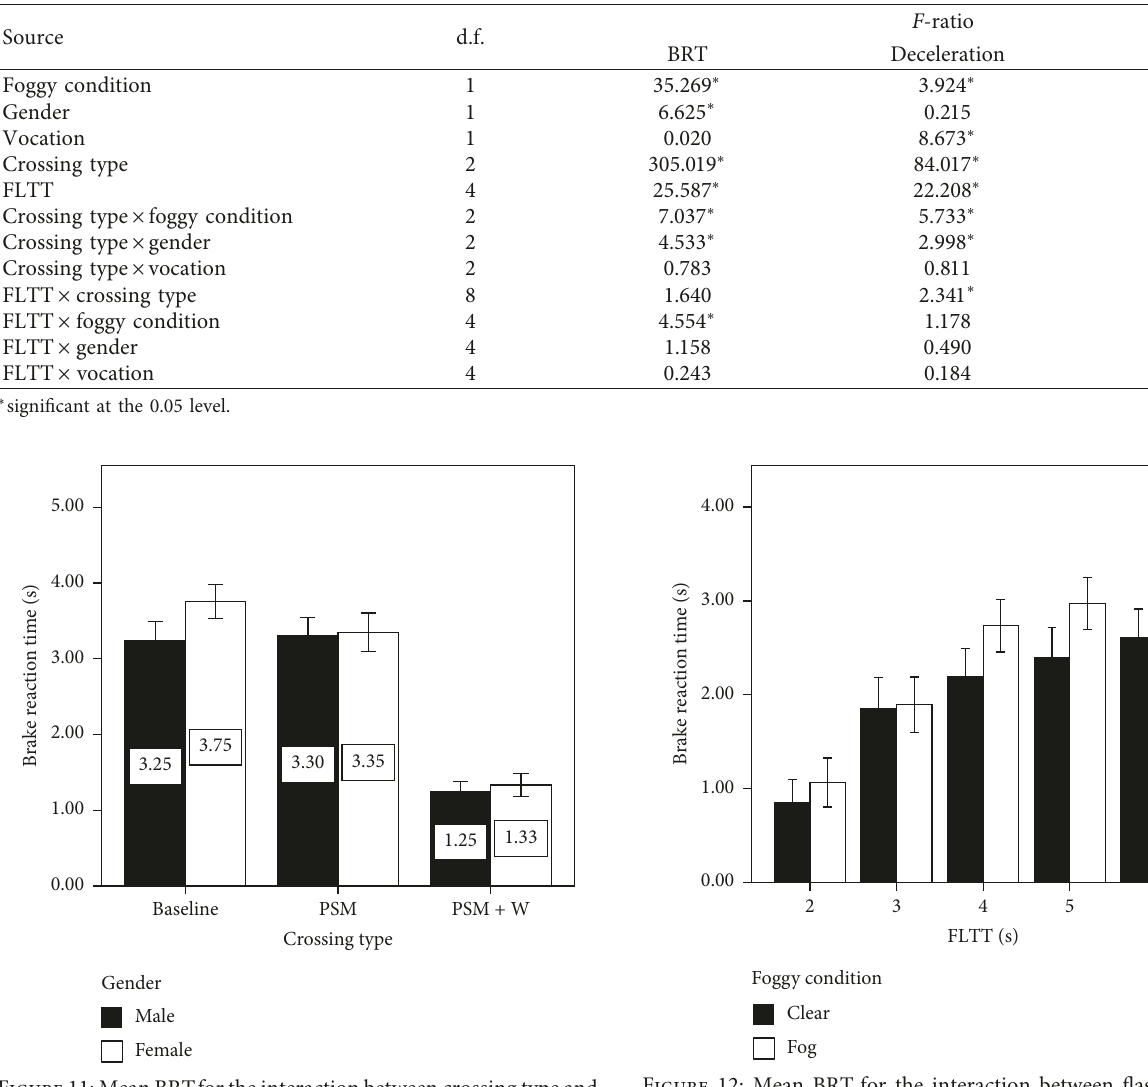
Table 5: Results of ANOVA for dependent measures.